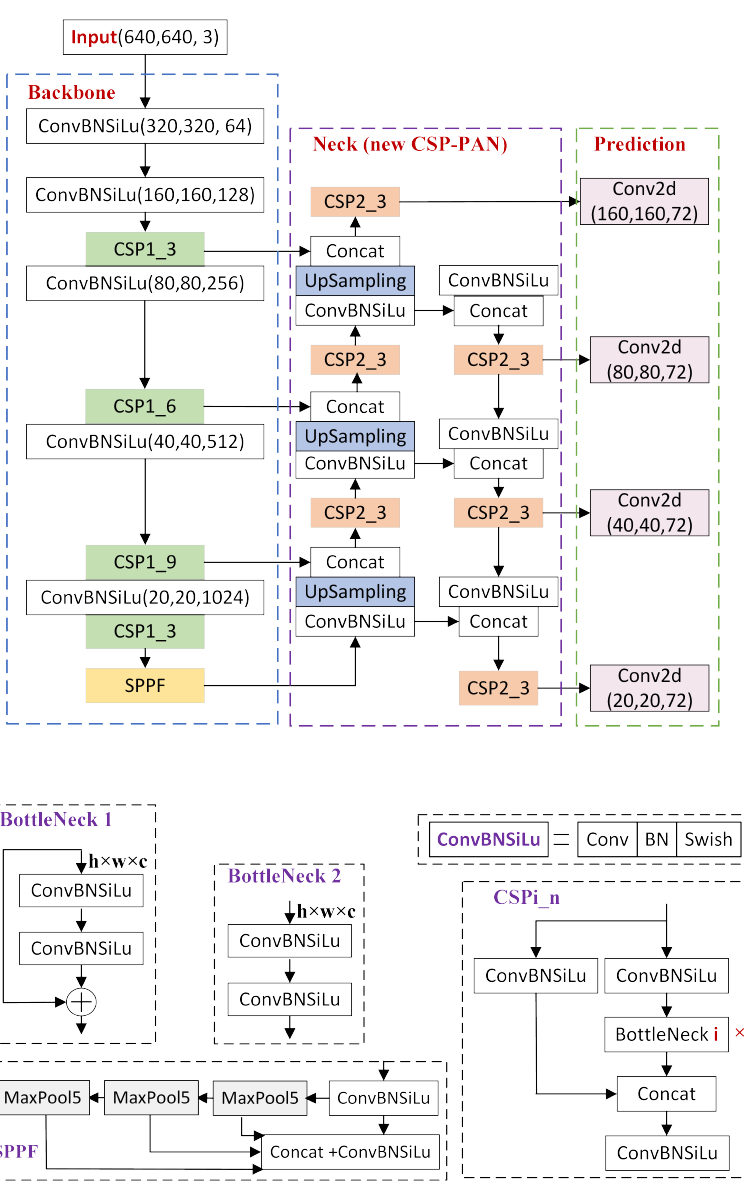
Figure 8. The configuration of the modified